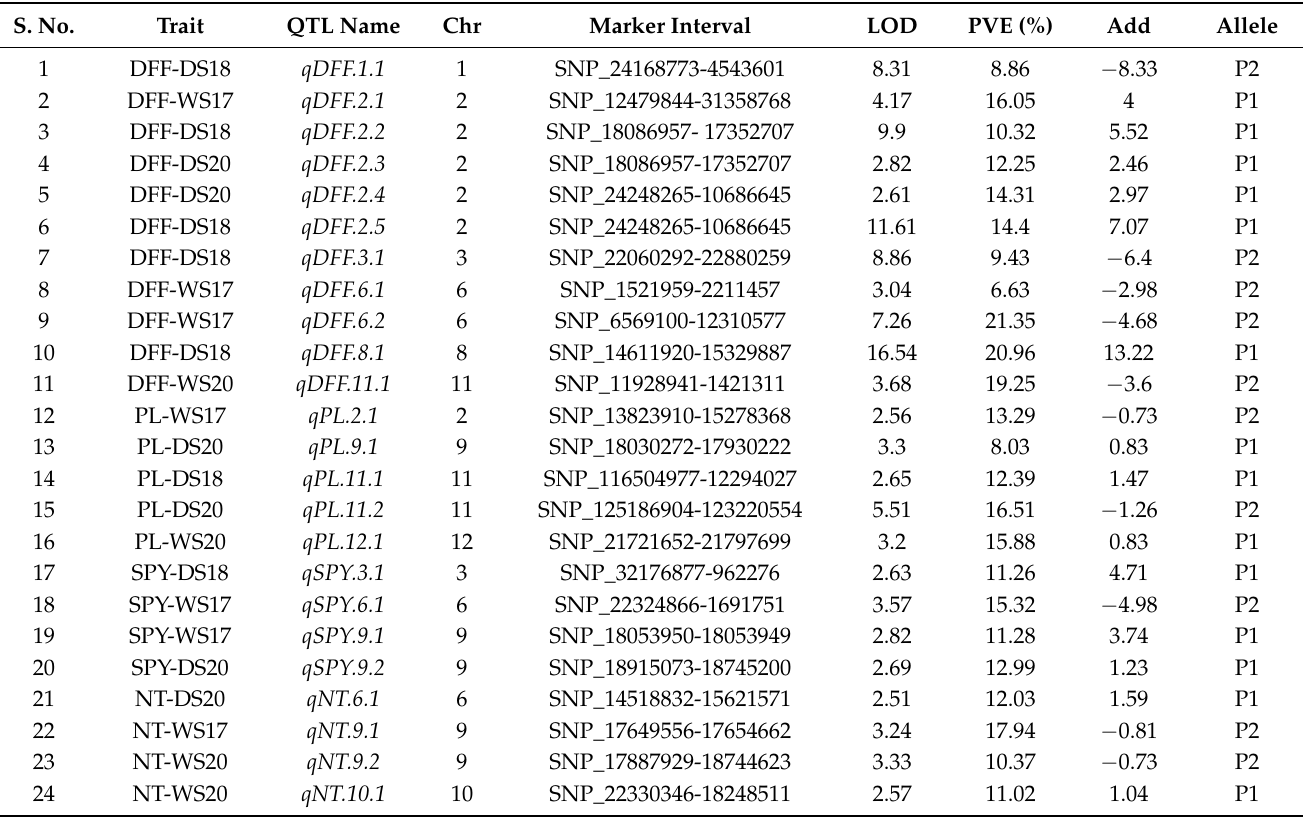
Table 6. Summary of major and minor QTLs for agronomic and yield related